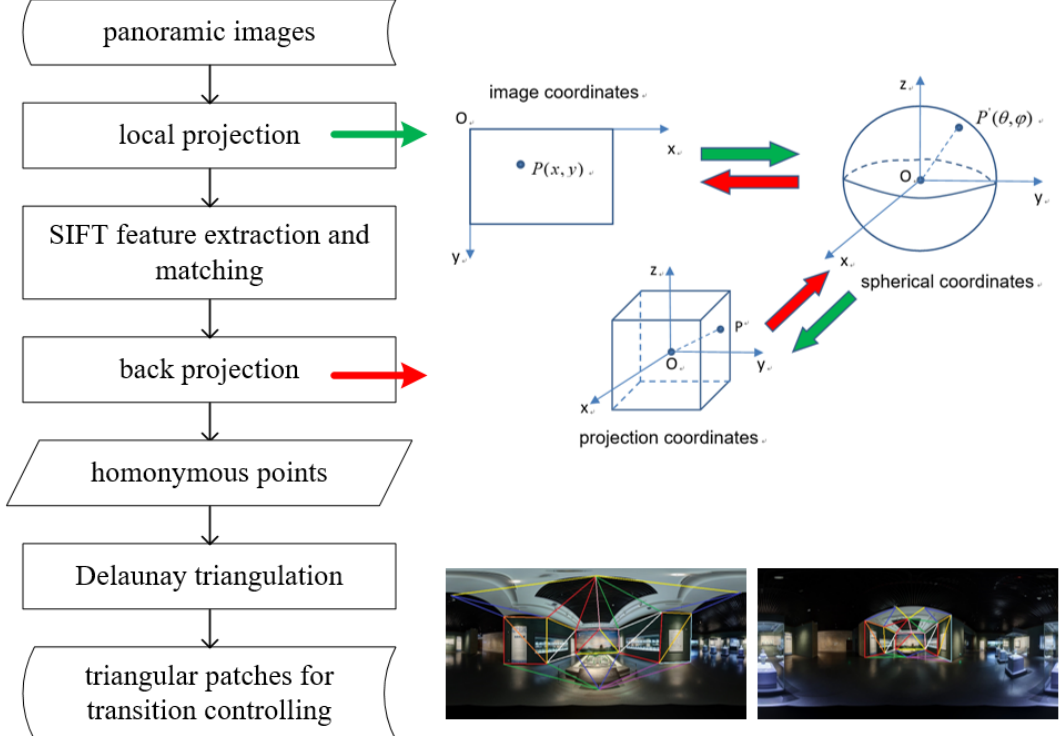
Figure 3. Generation flow chart of triangular patches for controlling transition. The green arrow represents the direction of execution of the local projection, and the red arrow represents the direction of execution of the back projection. The picture at the bottom right shows the extracted control triangular patches.